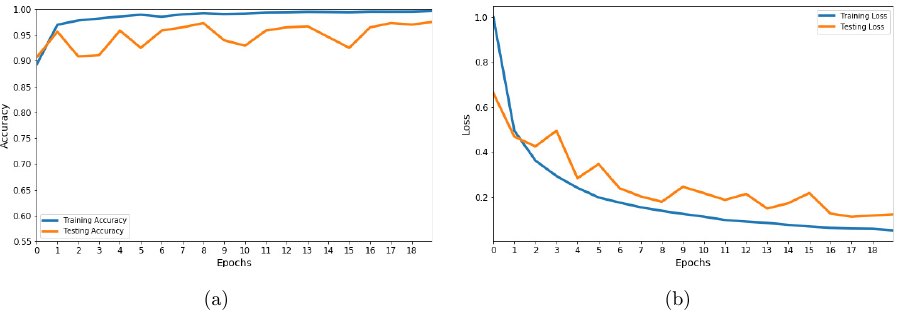
Fig. 10. Graph of the ResNet50 þ FCN model: (a) Epochs vs. Accuracy and (b) Epochs vs. Loss.